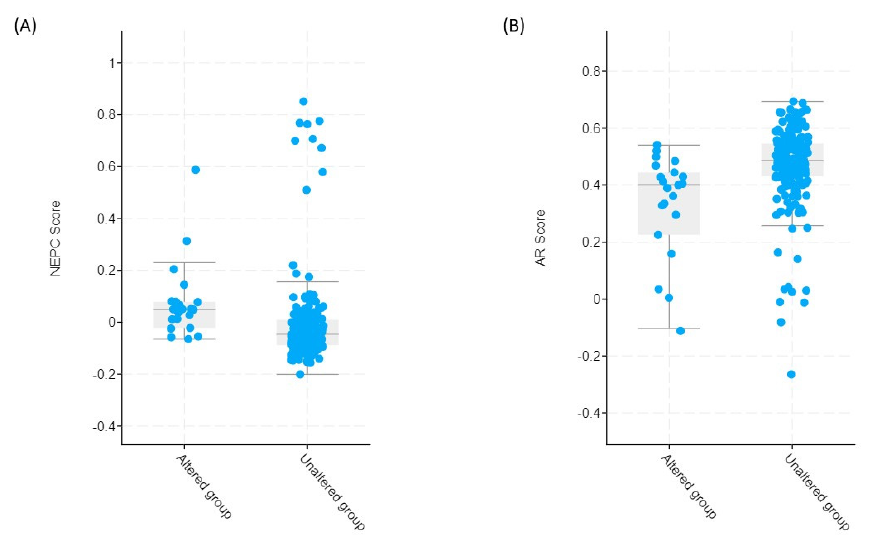
Figure 6. NEPC ( A ) and AR ( B ) scores in mCRPC patients with altered (high) and unaltered tumor